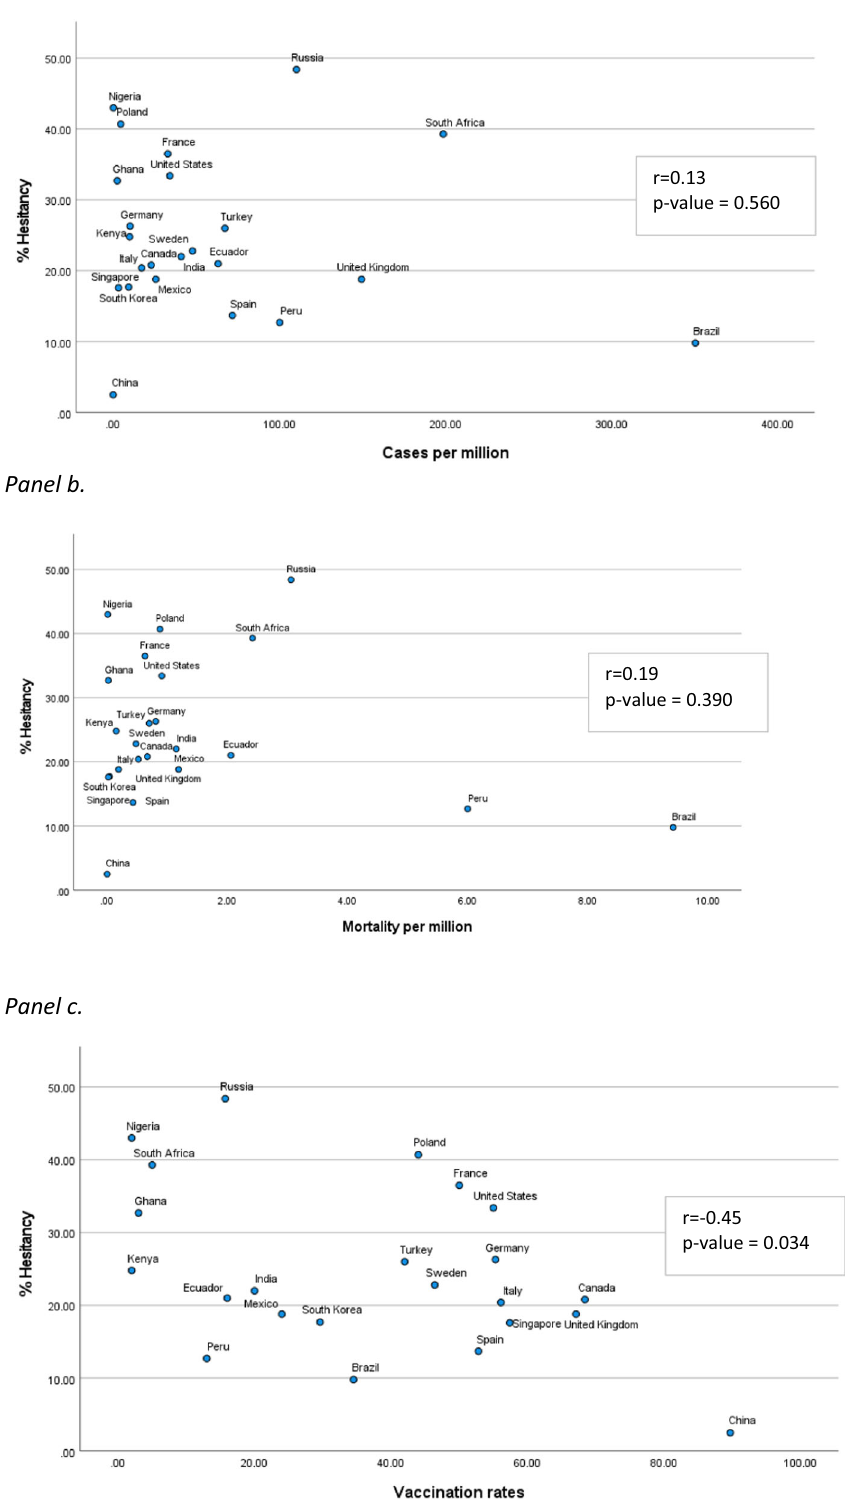
Fig. 2 COVID-19 vaccine hesitancy by current cases and mortality. a COVID-19 vaccine hesitancy and COVID-19 cases. b COVID-19 vaccine hesitancy and COVID-19 mortality. a , b Source data are provided in a Source Data fi le. c Vaccination rates and COVID-19 vaccine hesitancy. c The association between a country ’ s COVID-19 vaccine hesitancy and COVID-19 cases and mortality (per million population) at the time of survey were each assessed using Pearson correlations and associated p-values based on two-sided tests. No adjustments for multiple analyses were made. Source data are provided in a Source Data fi